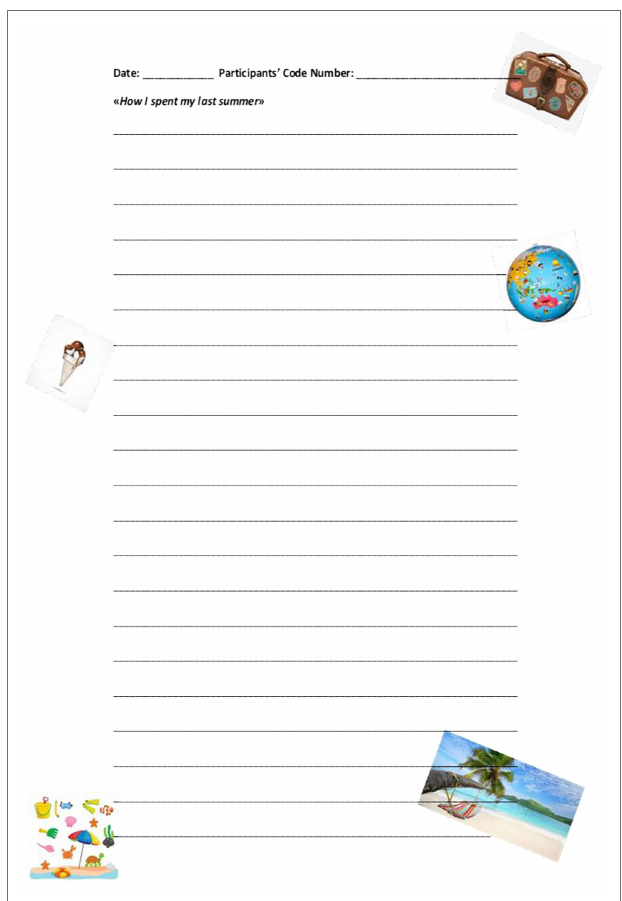
FIGURE 1 | The answer sheet given to each participant